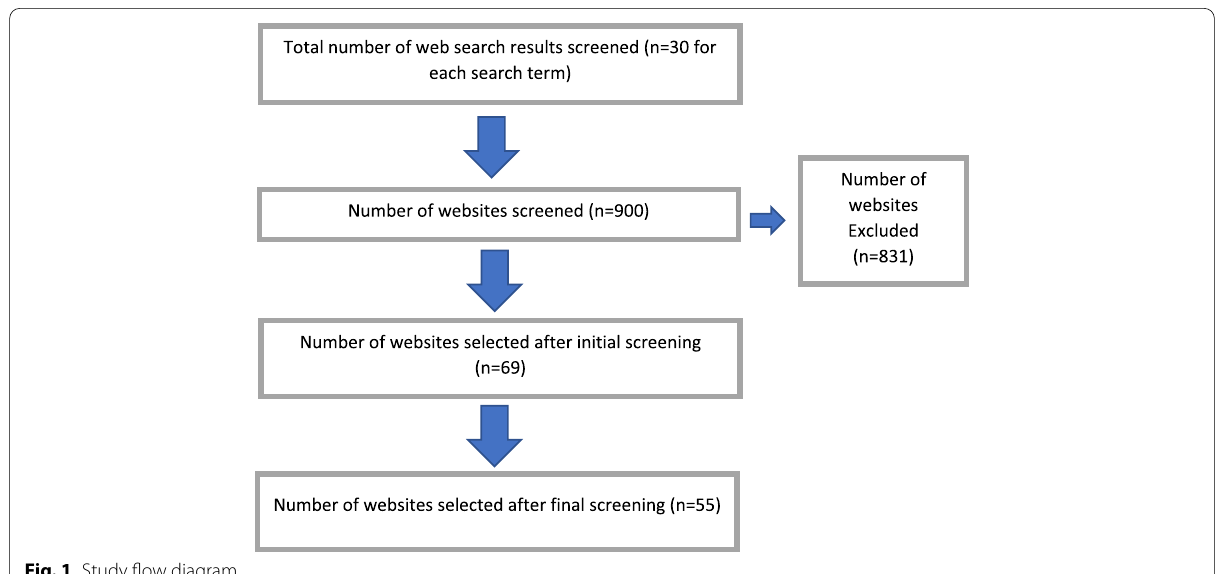
Fig. 1 Study flow diagram